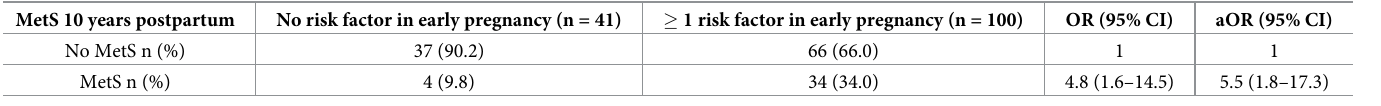
Table 2. Risk for metabolic syndrome 10 years postpartum based on presence or absence of cardio metabolic risk factors during early first pregnancy. MetS 10 years postpartum